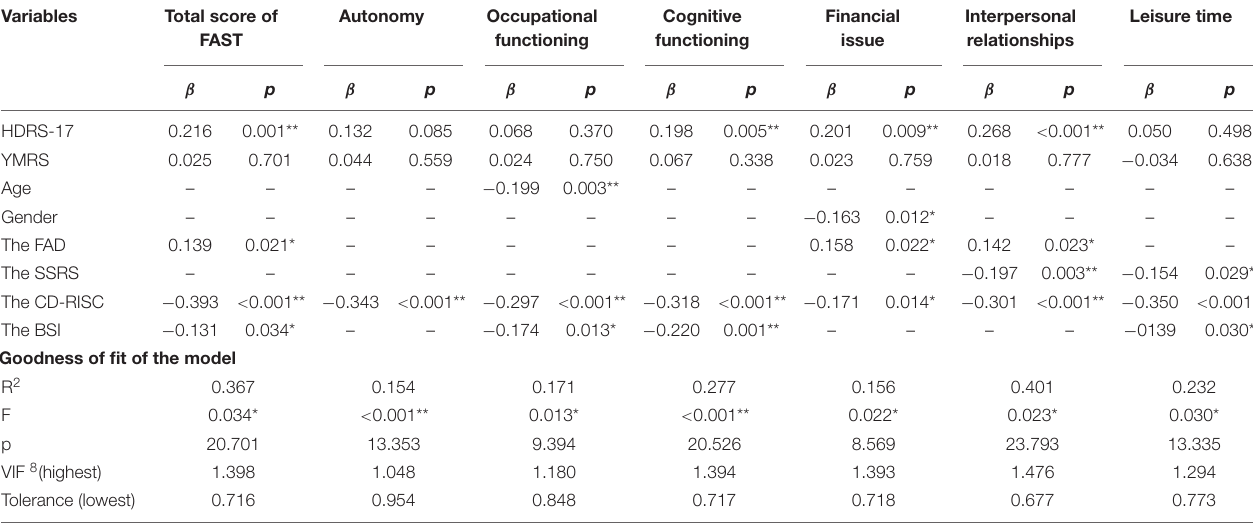
TABLE 4 | Results of predicting effects of family functioning, social support, suicidal ideation, and resilience on psychosocial functioning. Variables